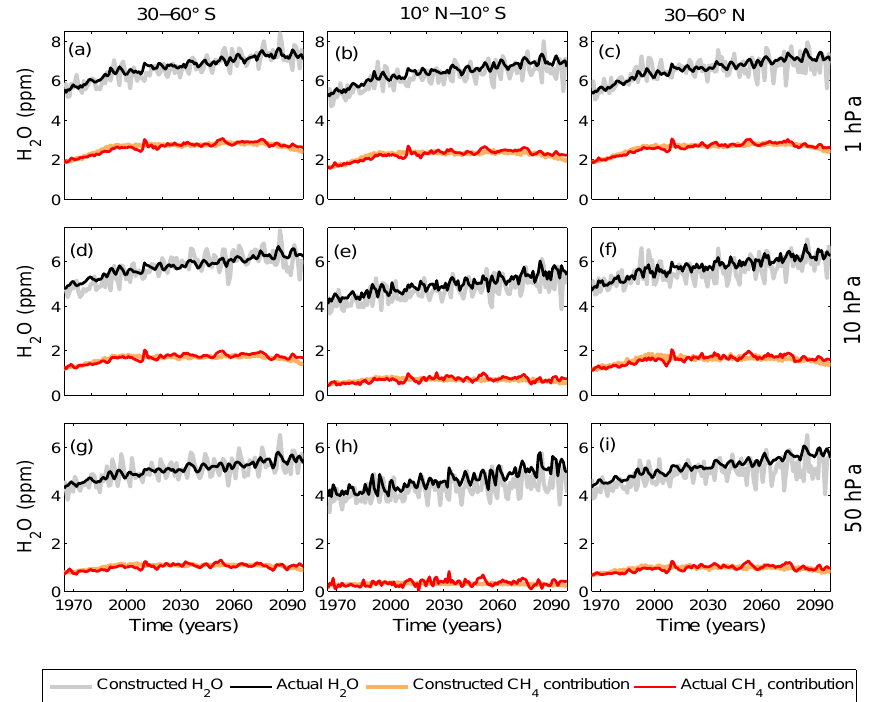
Figure 6. Constructed SWV (grey lines), actual SWV (black), the constructed methane contribution (orange) and the actual methane con- tribution (red) to SWV in the RCP 6.0-fEmis simulation. Top row: upper stratosphere (1hPa). Centre row: middle stratosphere (10hPa). Bottom row: lower stratosphere (50hPa). Left column: southern mid-latitudes (30–60 ◦ S). Centre column: tropics (10 ◦ N–10 ◦ S). Right col- umn: northern mid-latitudes (30–60 ◦ N). See text for details on how the methane contributions were calculated. All quantities shown are annual means.